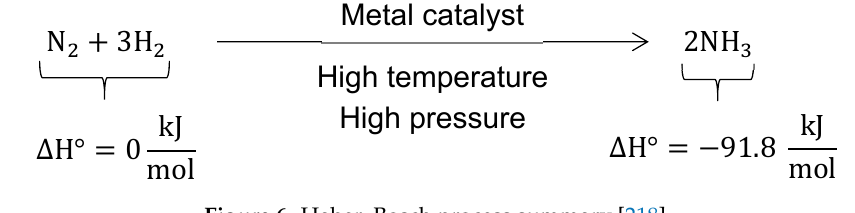
Figure 6. Haber–Bosch process summary [218].